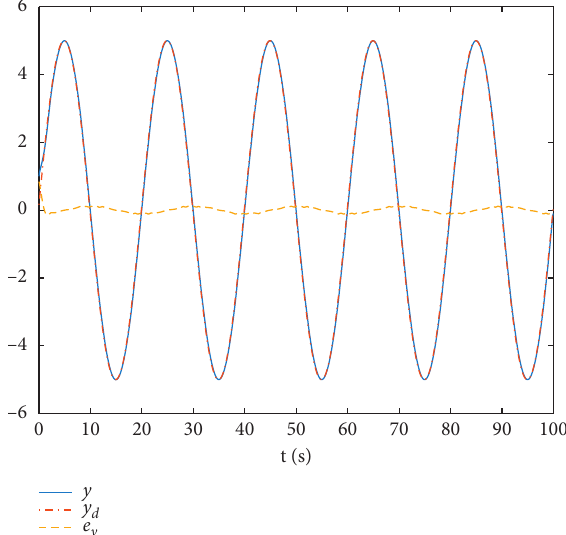
Figure 3: Trajectories of position y , ideal position y